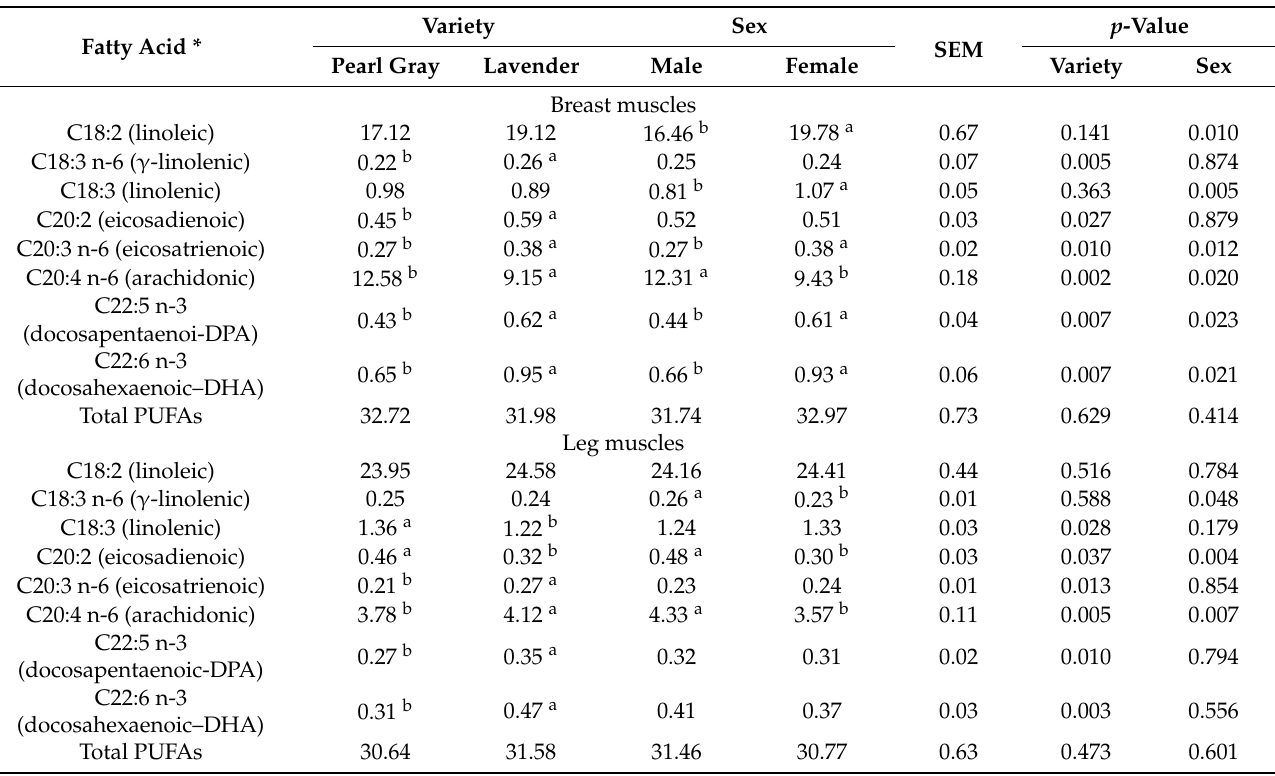
Table 8. Proportions (%) of polyunsaturated fatty acids in the total fatty acid pool in the intramuscular fat (breast and leg muscles) of female and male guinea fowl of pearl gray and lavender varieties (means ±